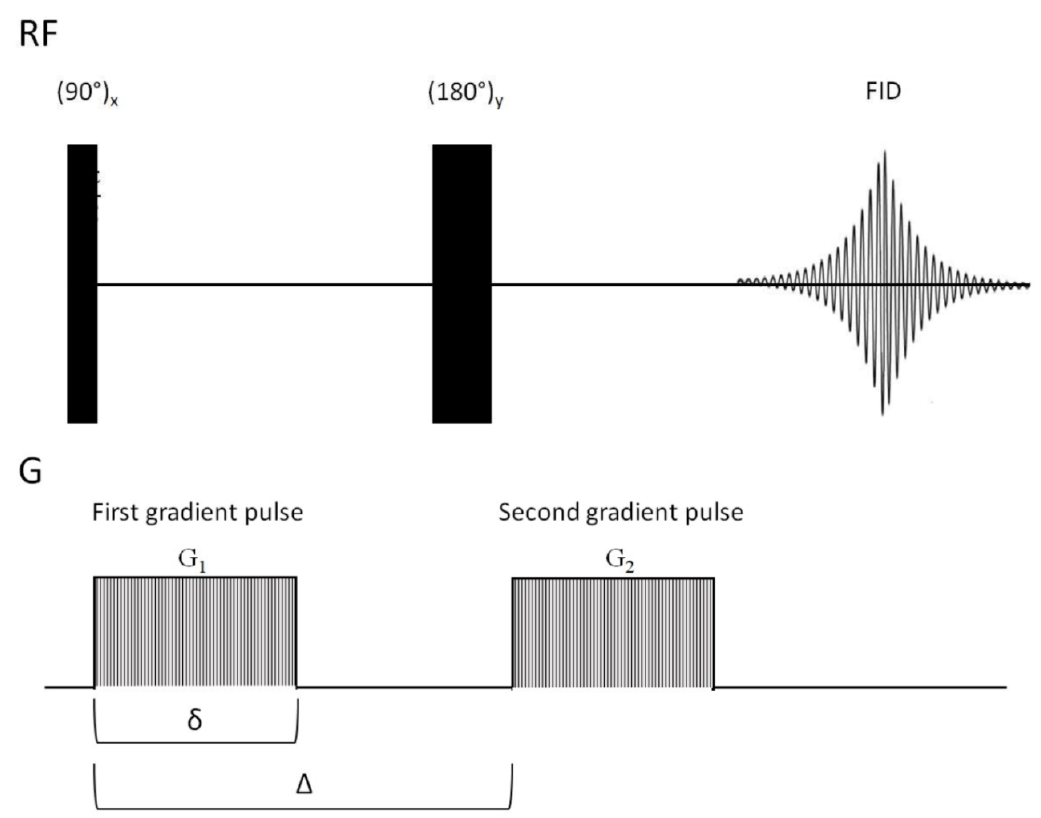
Figure 12. Spin echo (SE) sequence, as discovered by Stejskal et al. [293]. G 1 is the first gradient pulse applied after the first 90° pulse, and G 2 is the second gradient pulse applied after the first 180° pulse. δ and ∆ are the gradient length, and diffusion time, respectively.